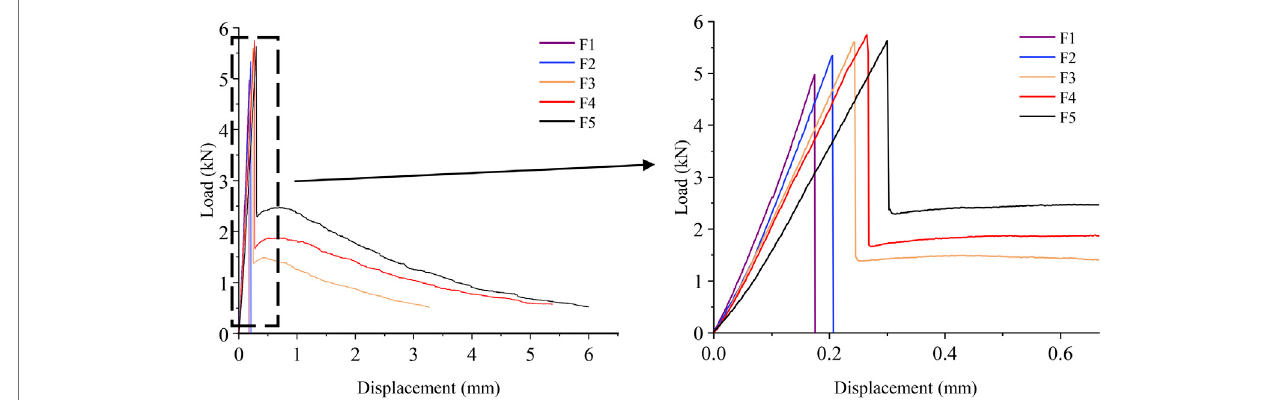
FIGURE 11 | Flexural load-displacement curve and enlarged view.